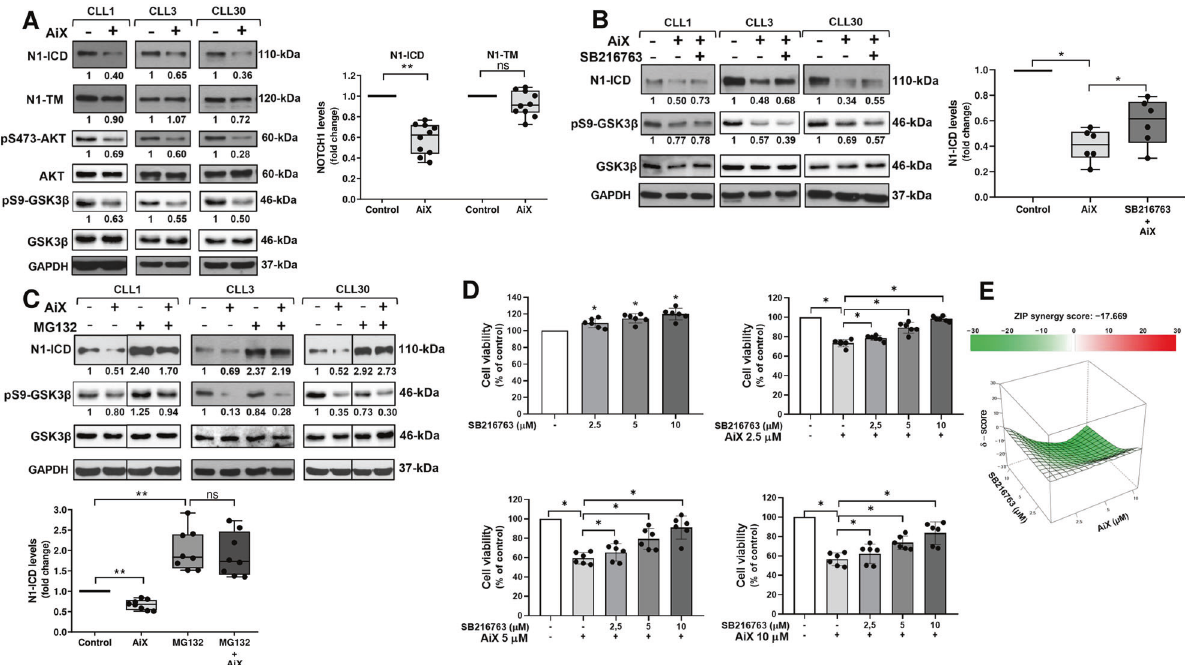
Fig. 5 Pharmacologic AKT inhibition reduces N1-ICD levels and CLL cell viability by promoting GSK3 β activity. A CLL cells were cultured for 6 h with 5 μ M AKTiX (AiX) or complete medium as control ( n = 10). Western blot analysis of NOTCH1 was performed using the anti-NOTCH1 (Val1744) and the anti-NOTCH1 (D1E11) antibodies, able to recognize N1-ICD and N1-TM, respectively. Protein loading was assessed using an anti-GAPDH antibody. Left, the values under each blot indicate the fold change in N1-ICD and N1-TM levels in AiX-treated cells compared with control cells (set to 1), normalized to GAPDH levels. AKT Inhibition by AiX was veri fi ed by analyzing AKT phosphorylation at Serine 473 (pS473- AKT). The effect of AiX on GSK3 β inactivation was assessed by analyzing pS9-GSK3 β levels. The values under each blot indicate the fold change in pS473-AKT and pS9-GSK3 β levels in AiX-treated cells compared with control cells (set to 1), normalized to levels of total AKT and total GSK3 β , respectively. Three CLL samples are shown. Right, box and whisker plots with data points of densitometry analysis of N1-ICD and N1-TM, represented as fold change compared with controls. ** P < 0.01; ns, not signi fi cant according to Wilcoxon paired test. B CLL cells were cultured for 1.5 h with 5 µM SB216763 or DMSO and for further 6 h with 5 µM AiX ( n = 6). Western blot analysis of N1-ICD, pS9-GSK3 β , total GSK3 β and GAPDH was performed as in panel A. Left, the values under the blots indicate the fold change in N1-ICD and pS9-GSK3 β levels in cells treated with AiX alone or AiX plus SB216763, compared with control cells (set to 1), normalized to levels of GAPDH and total GSK3 β , respectively. Three CLL samples are shown. Right, box and whisker plots with data points of densitometry analysis of N1-ICD, represented as fold change compared with control. * P < 0.05 according to Wilcoxon paired test. C CLL cells were pretreated for 2 h with 10 μ M MG132 or DMSO, and then cultured for further 6 h with or without 5 μ M AiX ( n = 8). Western blot analysis of N1-ICD, pS9-GSK3 β , total GSK3 β and GAPDH was performed as in panel A. Top, the values under the blots indicate the fold change in N1-ICD and pS9-GSK3 β levels in cells treated with AiX, MG132, or AiX plus MG132, compared with control cells (set to 1), normalized to levels of GAPDH and total GSK3 β , respectively. Three CLL samples are shown. Vertical lines inserted in CLL1 and CLL30 blots indicate repositioned gel lanes. Bottom, box and whisker plots with data points of densitometry analysis of N1-ICD, represented as fold change compared with control. ** P < 0.01; ns, not signi fi cant according to Wilcoxon paired test. D , E CLL cells were cultured with or without different concentrations of AiX (2.5, 5 and 10 µM) or SB216763 (2.5, 5 and 10 µM) alone or in combinations ( n = 6). After 18 h, cell viability was measured by MTS assay. D Bar graphs with data points of cell viability (mean ± SD) in treated cells compared with untreated controls, set to 100%. * P < 0.05 according to Wilcoxon paired test. E The antagonism between SB216763 and AiX was calculated by using the SynergyFinder web application and the results were produced with ZIP Synergy model (green indicates an antagonistic effect, white an additive effect, and red a synergistic increased percentage of An V + cells (An V + /PI - plus An V + /PI + ) (Fig. 6A, left and right panels). The apoptotic effect of DT-061 on CLL cells was also supported by the increased cleavage of PARP and the reduced expression of the antiapoptotic Mcl-1 protein observed in DT-061-treated cells compared with controls ( n = 8; Fig. 6B). To assess whether GSK3 β activity mediated the apoptotic